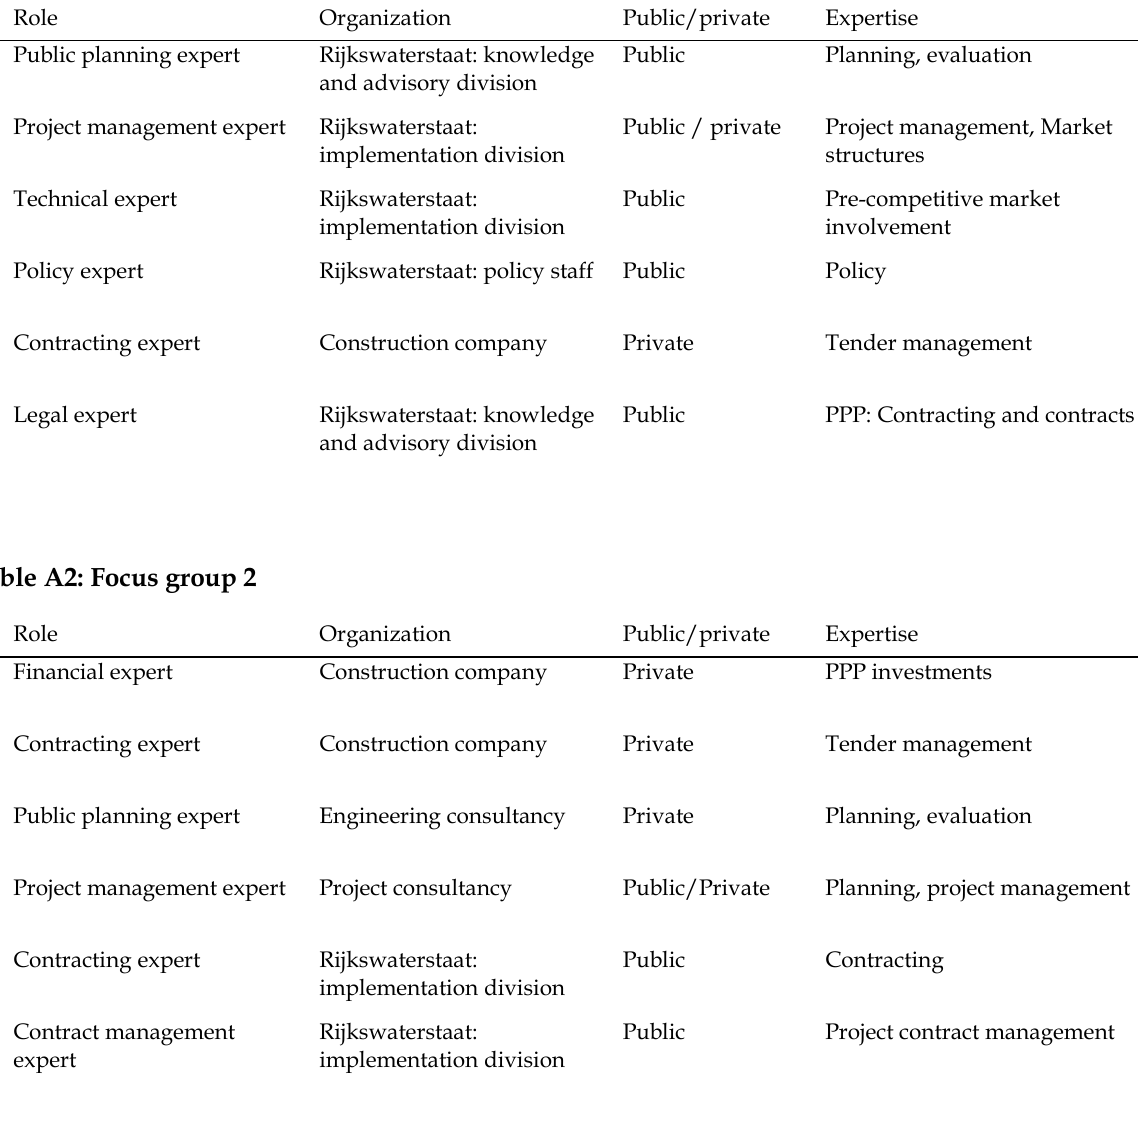
Table A1: Focus group 1